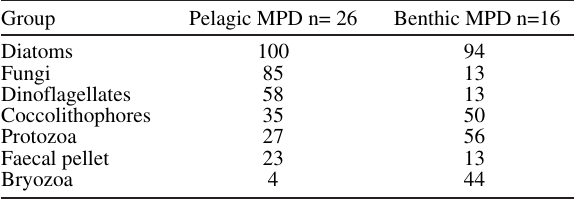
Table 1. – Frequency of occurrence (%) of the most abundant taxo- nomic group on pelagic and benthic marine plastic debris